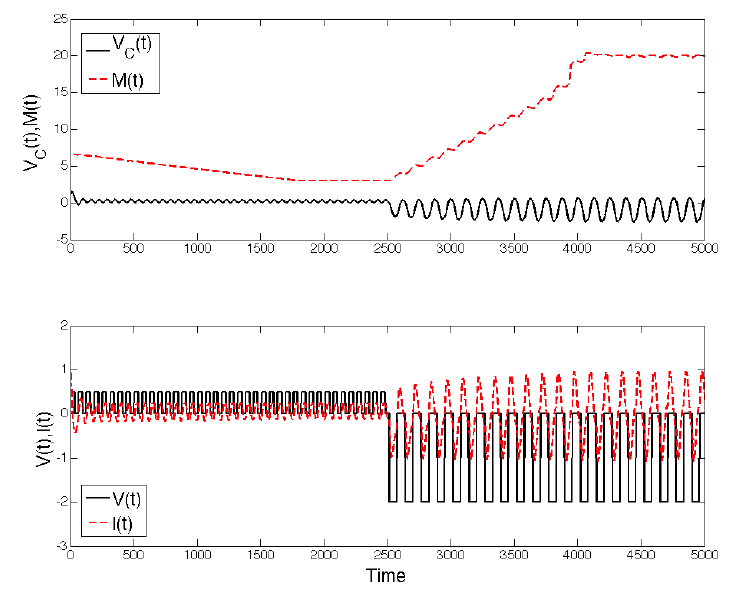
Figure 12. Simulation of Equation (49) and adaptation of the circuit to different stimuli. We consider the parameters β = 100, α = 0.1, R 1 = 3, R 2 = 20, C = 1, R = 1, L = 2, V t = 2.5 as in [138]. We stimulate the circuit with a square input V ( t ) = 0.5 and frequency ω = 10 and then with reduce by a half the frequency, with V ( t ) = 2. We see that the circuits “adapts” to the new stimulus after a transient. − Initial conditions were I 0 = 1, V 0 c = 1, R ( 0 ) = 7 and used an Euler integration scheme with step dt =